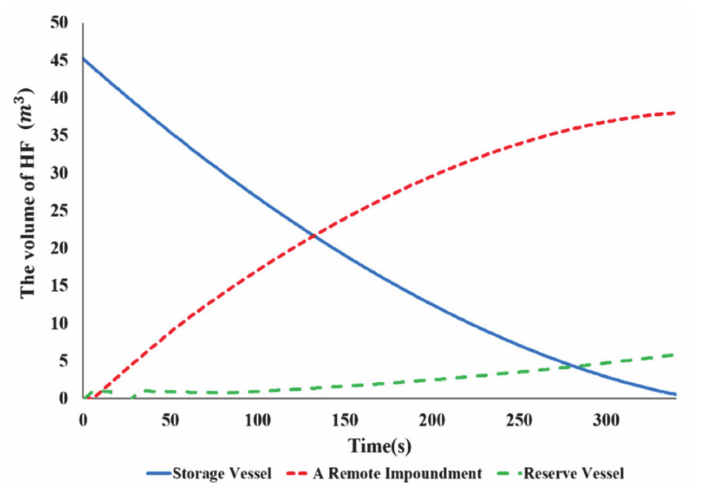
Figure 3. The volume of the HF in the storage vessel, a remote impoundment and a reserve vessel when a leak of the HF from the storage vessel occurs. The diameter of the leak hole is 6 inch.